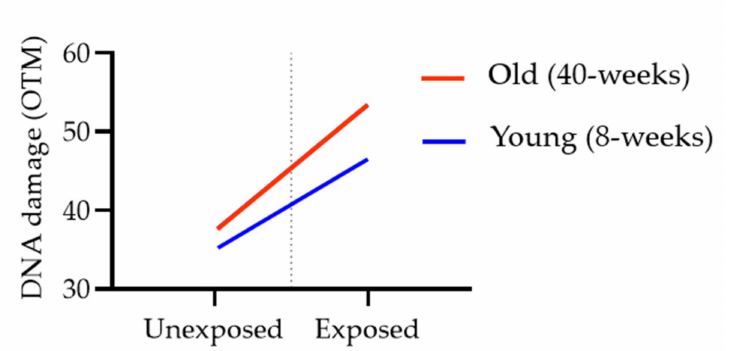
Figure 5. Interaction plot for DEP exposure ×